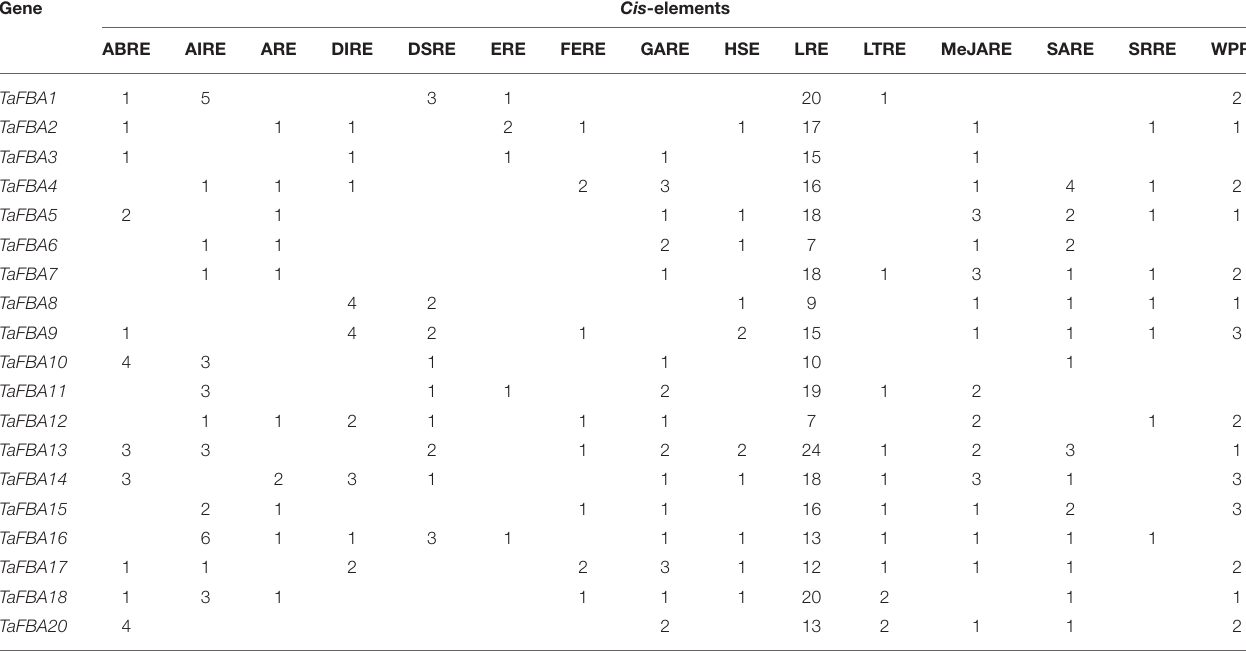
ABA-responsive elements (ABRE), Auxin-responsive elements(ARE), GA-responsive elements (GARE), Low-temperature responsive elements (LTRE), Light-regulated elements (LRE), Drought-induced elements (DIRE), Ethylene-responsive elements(ERE), Fungal-elicitor responsive elements (FERE), SA-responsive elements (SARE), MeJA-responsive elements (MeJARE), Anaerobically-induced elements (AIRE), Heat-stress responsive elements (HSRE), Sugar-repression responsive elements (SSRE), Wounding-and pathogen-responsive elements (WPRE) and Defense- and stress-responsive elements